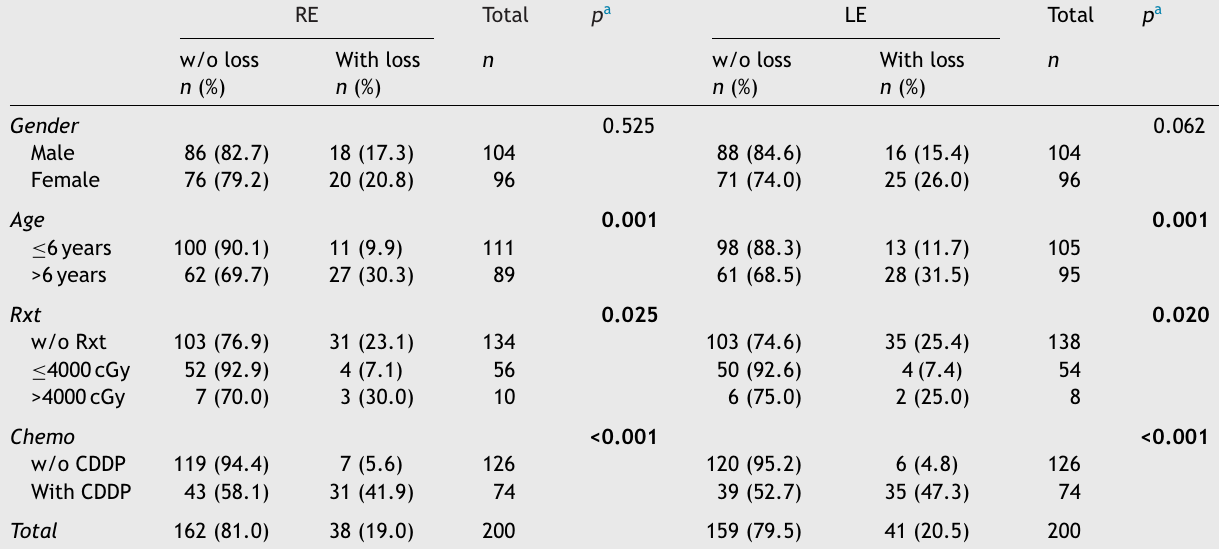
Distribution of patients who met the hearing loss criteria in relation to the factors studied: sex, age, radiation, and chemotherapy with CDDP (GEPETTO 2000---2004).